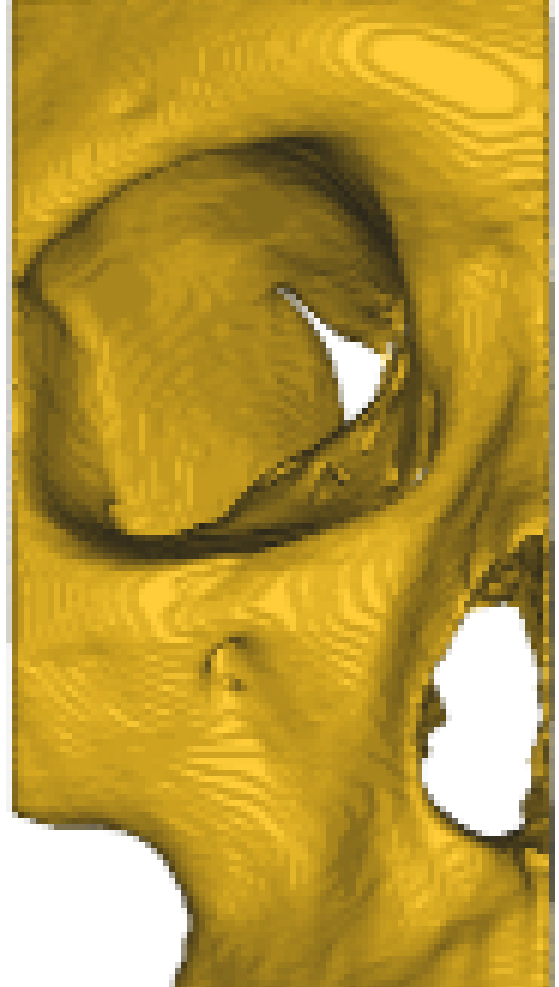
Figure 2. Cropping of